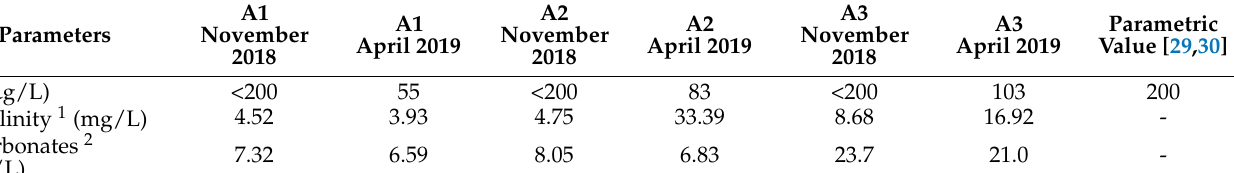
Table 1. Results of the chemical analysis on water samples from C á vado River.